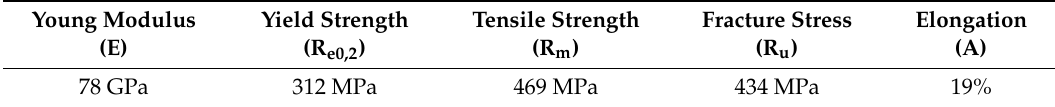
Figure 4. Tensile curve of AA2519-T62. Table 2. Mechanical properties of Sc-modified AA2519-T62 extrusion.